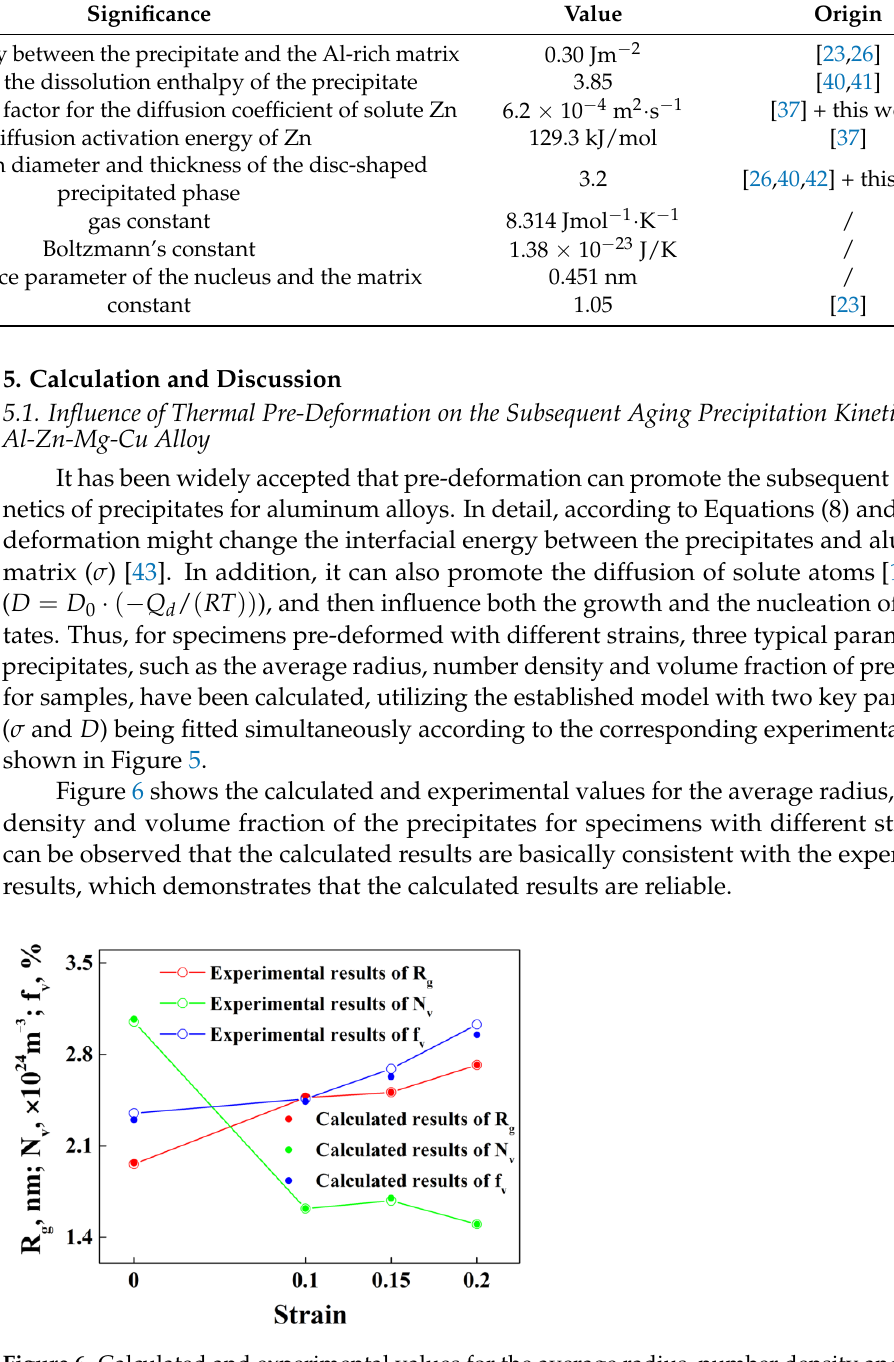
Figure 6. Calculated and experimental values for the average radius, number density and volume fraction of the precipitates for alloy samples with different